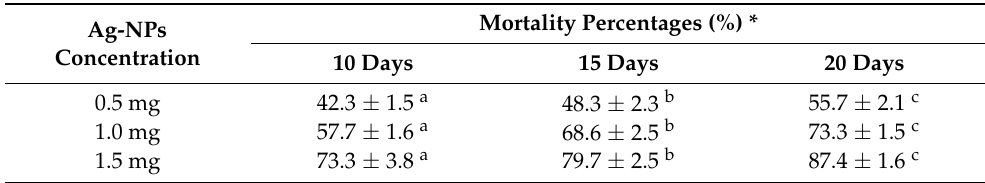
Table 1. The mortality percentages of green synthesized Ag-NPs against T. putrescentiae at different concentrations after interval